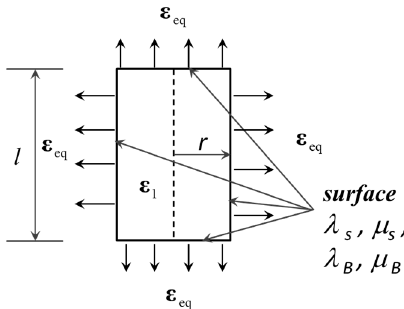
Figure 1. Schematic illustration of cylindrical inhomogeneity.